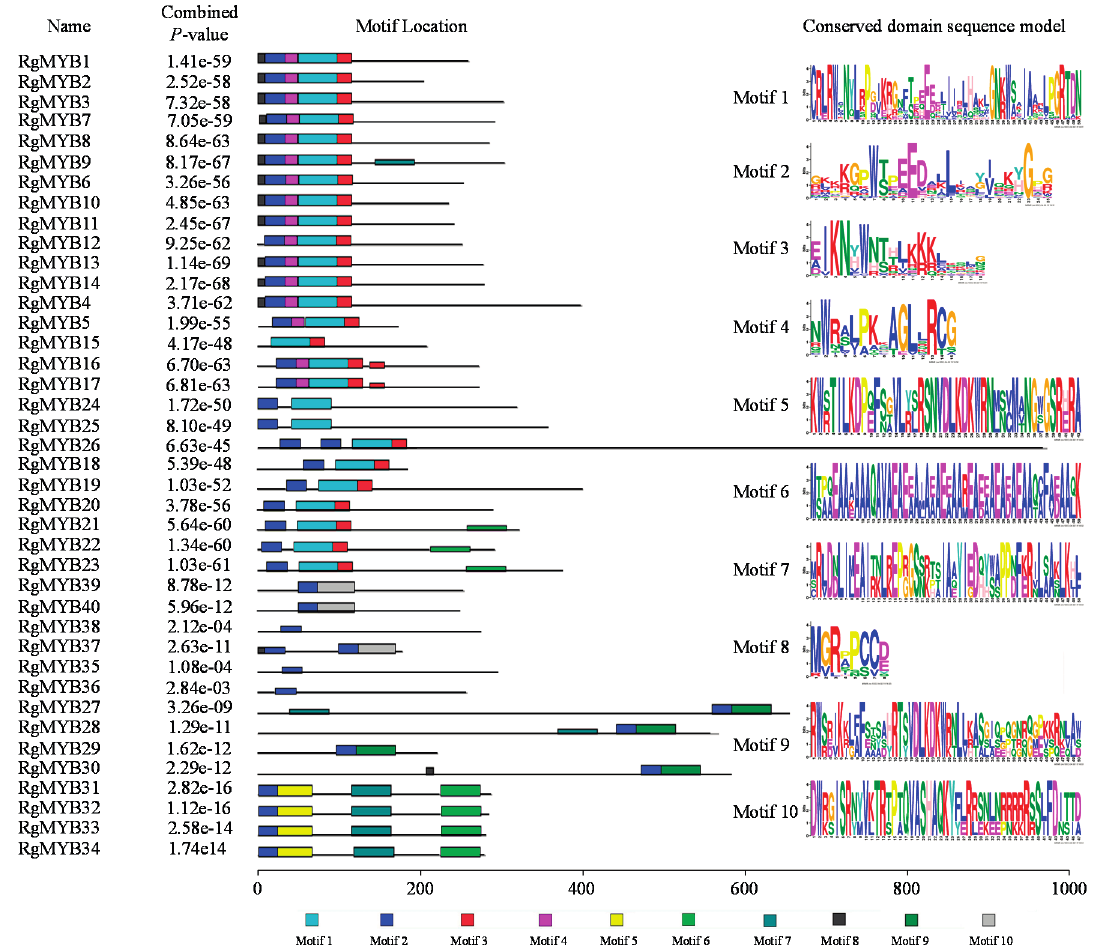
Figure 1. Schematic representation of conserved motifs in the MYB proteins of R. glutinosa , which were elucidated by MEME. Each motif is represented by a number in the colored box. The black lines represent the nonconserved sequences. The scale bar represents 200 amino